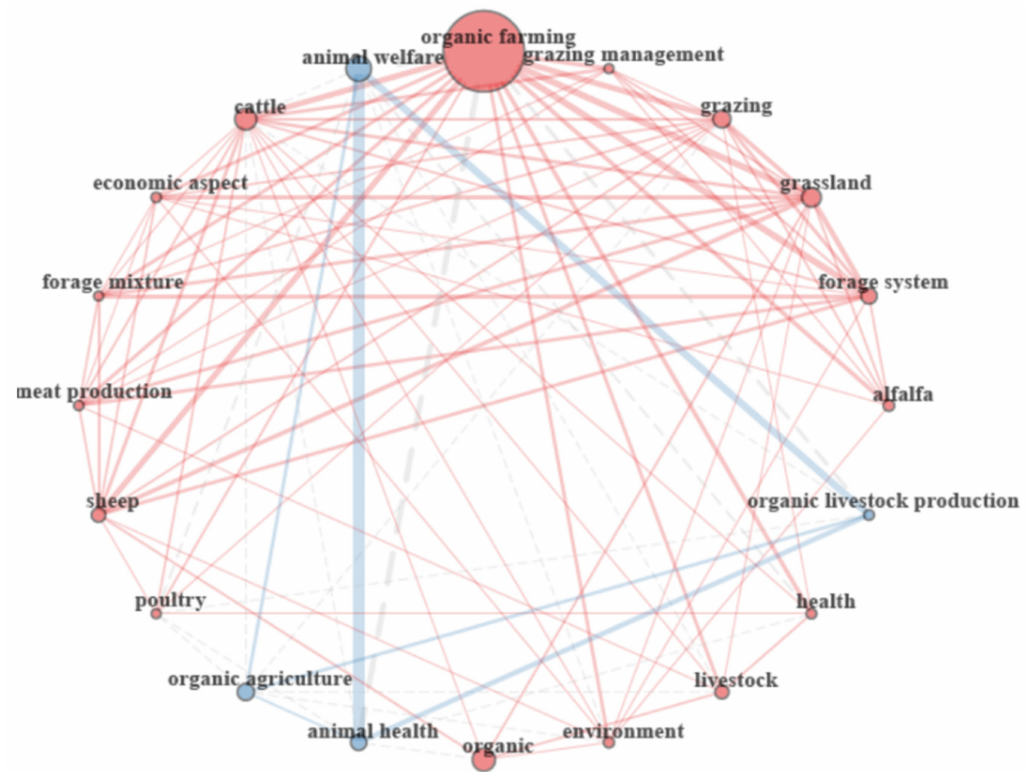
Figure 9. Network plot of the top 20 authors’ keywords co-occurrence using circle visualization. Each node size is proportional to the number of direct connections. The bigger the node, the more connections it has. Lines (link) between nodes represent direct connections and thickness is proportional to the number of studies involved in each direct connection. Node colors identify clusters of words using the Walktrap algorithm. Dash lines link nodes of di ff erent